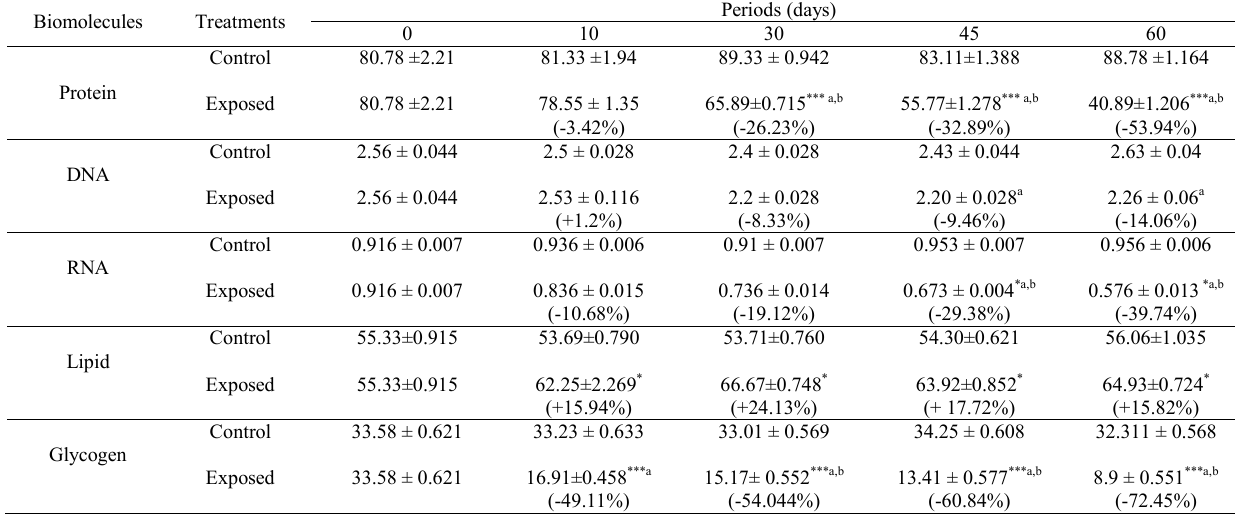
Table 3. Fluctuations in different biomolecules in the liver of Clarias batrachus at different period of exposure to 1 mg/L of sodium arsenite. Protein, DNA, RNA, lipid, and glycogen were expressed in mg/gm wet wt of tissue. Data are shown as mean ± SEM (n = 9). (%) Denote changes over respective controls. Two way ANOVA followed by Dunnett’s t -test. The criterion for significance was set at ( * ) p <0.05, ( ** ) p <0.01 and ( *** ) p <0.001. ( a ) Indicates when exposed groups were compared with 0 day controls and ( b ), when exposed groups were compared with previous exposed